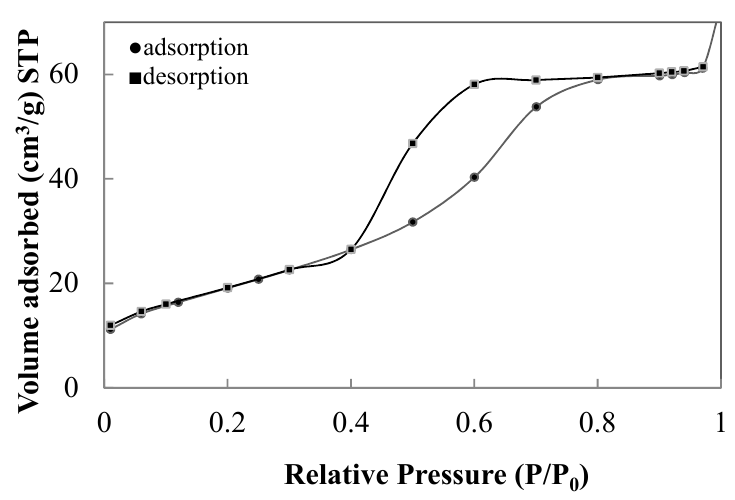
Figure 4. N 2 absorption-desorption curves of the sample T1 reported in Table 2.